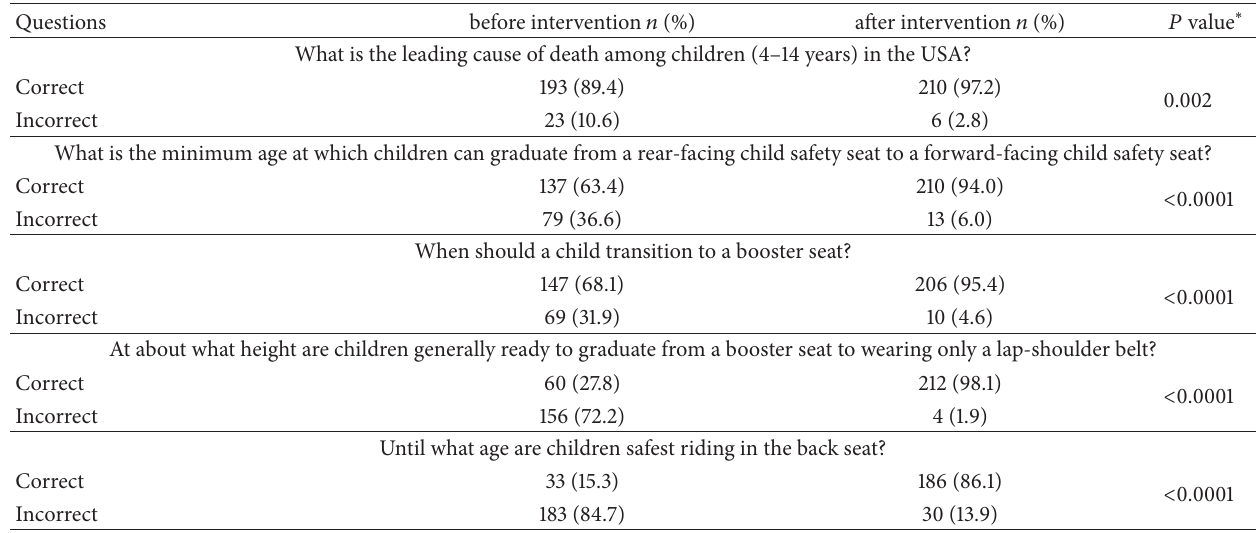
Table 2: Responses to child passenger safety questions before and after educational intervention: the ford see me safe child passenger safety education